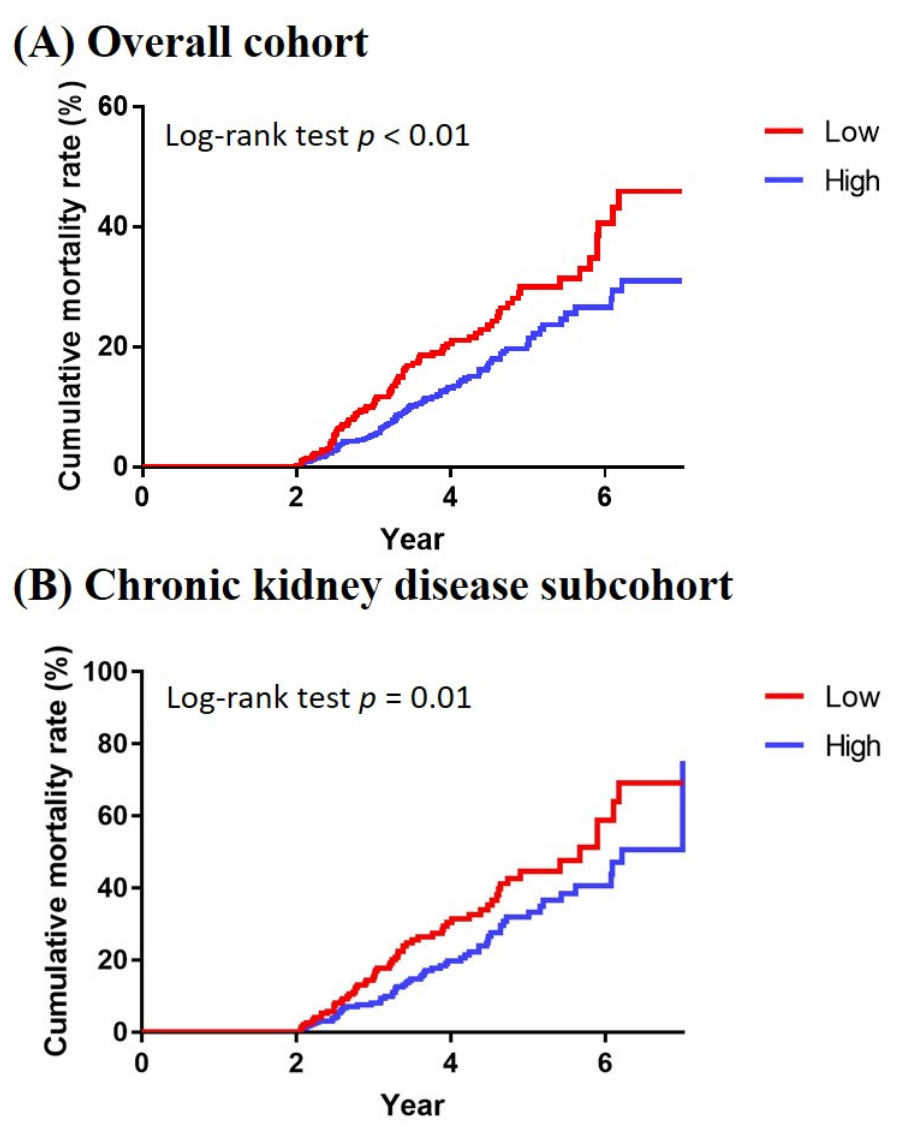
Figure 2. Kaplan–Meier curves for all-cause mortality, between high- and low-adherence denosumab users, in ( A ) overall cohort and ( B ) chronic kidney disease subcohort.